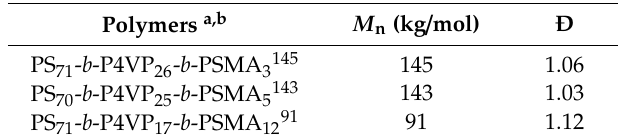
Table 1. Composition and molecular weights of polystyrene- b -poly(4-vinylpyridine)- b